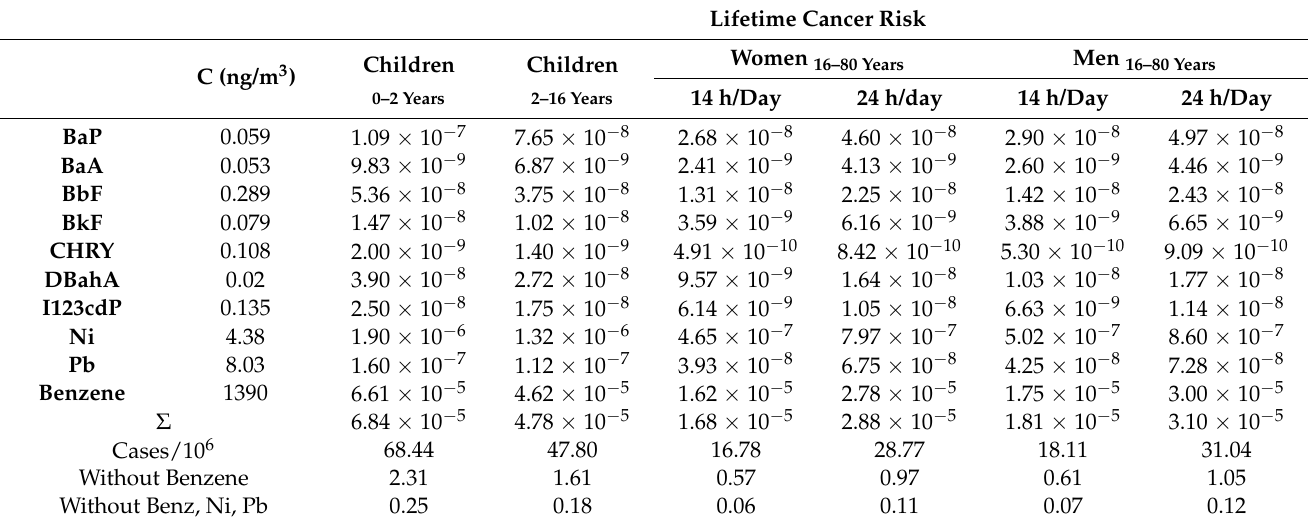
Table A13. Cancer risk assessment C.I method (Xu, 2018 / Farris, 2014).